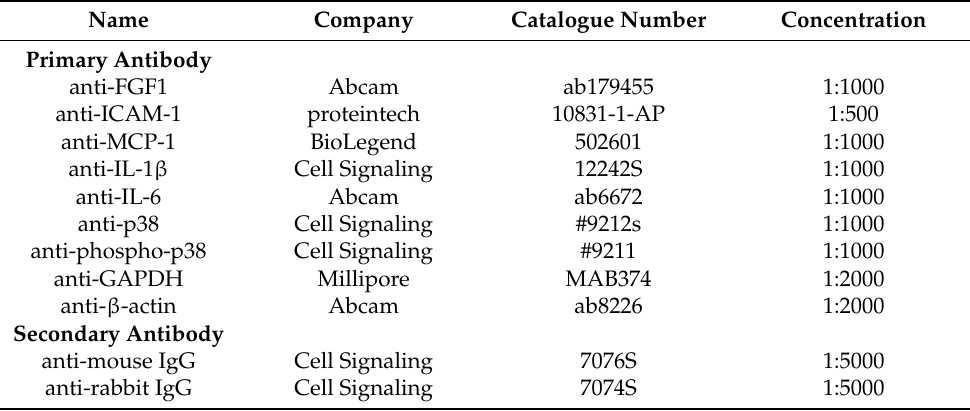
Table 3. List of WB primary and secondary